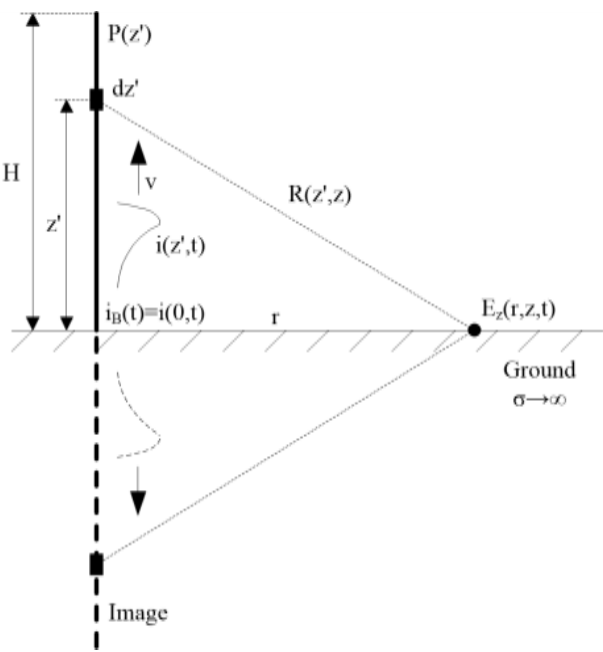
Figure 1. Geometric model of lightning electromagnetic pulse generation.